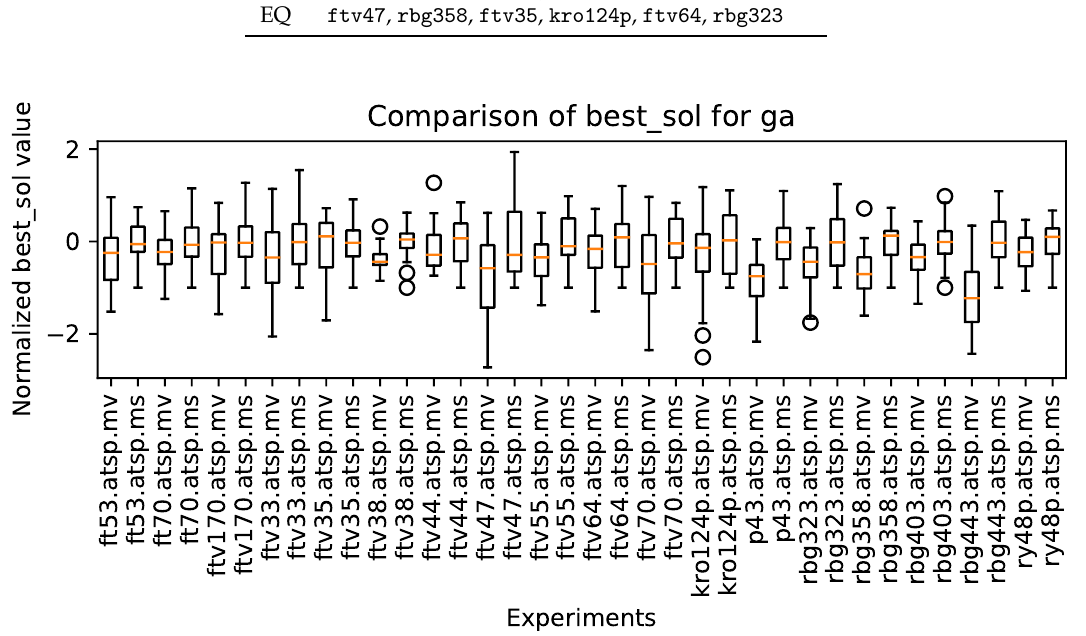
Figure 1. Boxplot of best cost achieved across the 25 runs for each instance problem using Multistart and Multiverse Genetic Algorithm. Costs are normalized to the corresponding average using Multistart so that they are comparable.